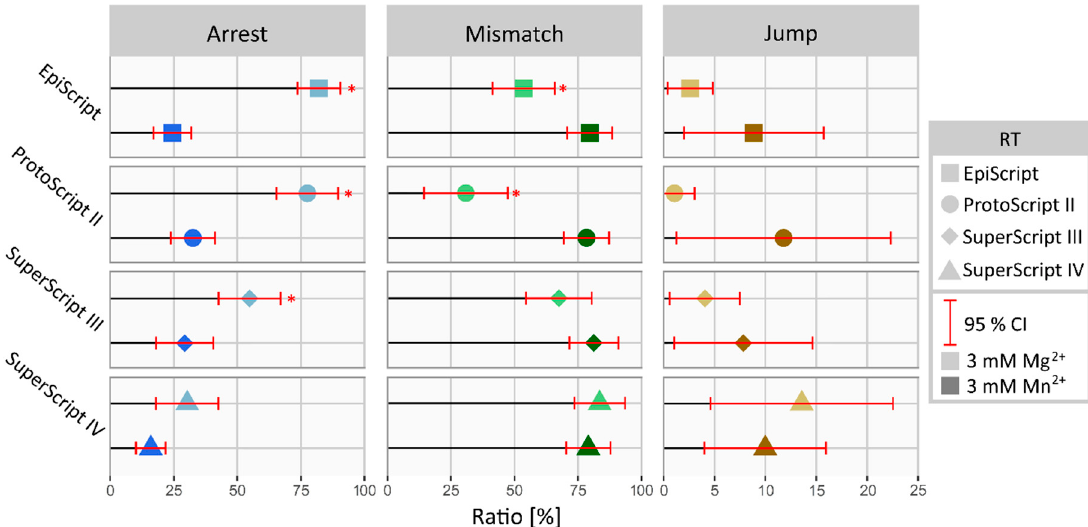
Figure 4. Comparative plot of all used polymerases breaking down their average profile for m 1 A positions in S. cerevisiae tRNA. The 95% confidence interval is displayed in red, with colored asterisk (*) indicating significant differences ( p -value < 0.05) between Mg 2+ and Mn 2+ conditions. Enzymes are displayed in different shapes with colors signaling Mg 2+ (pale) or Mn 2+ (intense) treatment.